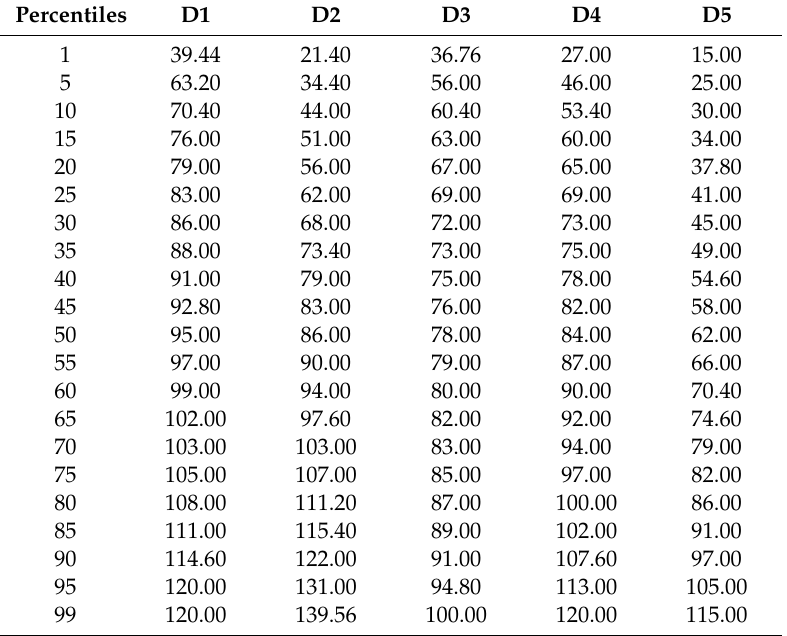
Table 3. Percentiles distribution of the HS-EBP five